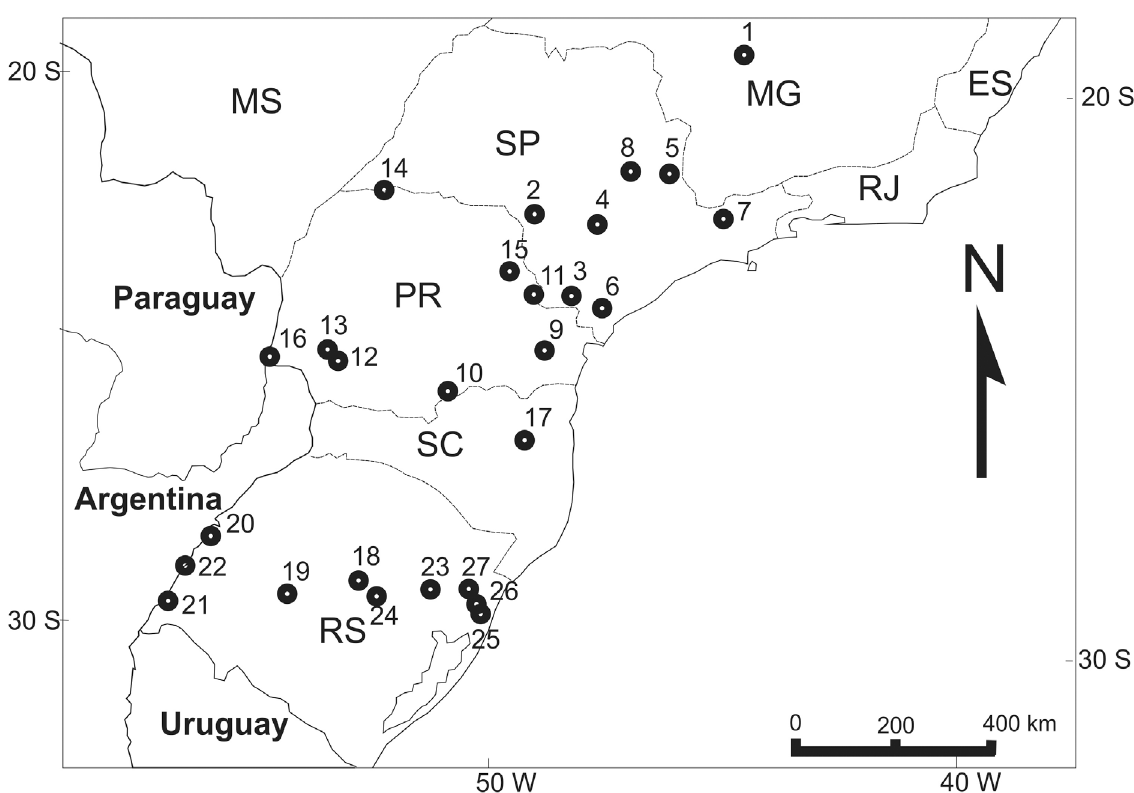
Figure 1: Archaeological sites from southern and southeastern Brazil presenting bifacial points dated from the Late Pleistocene to the eve of the historical period. The numbers refer to the column “map number” in Table